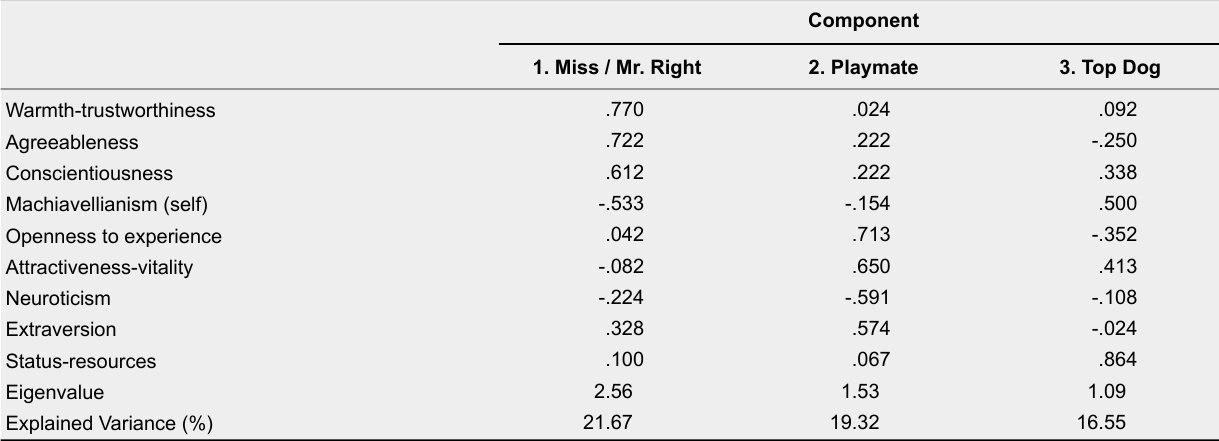
Results of Principal Components Analysis (With Varimax Rotation) of Machiavellianism and Ideal Partner Variables.